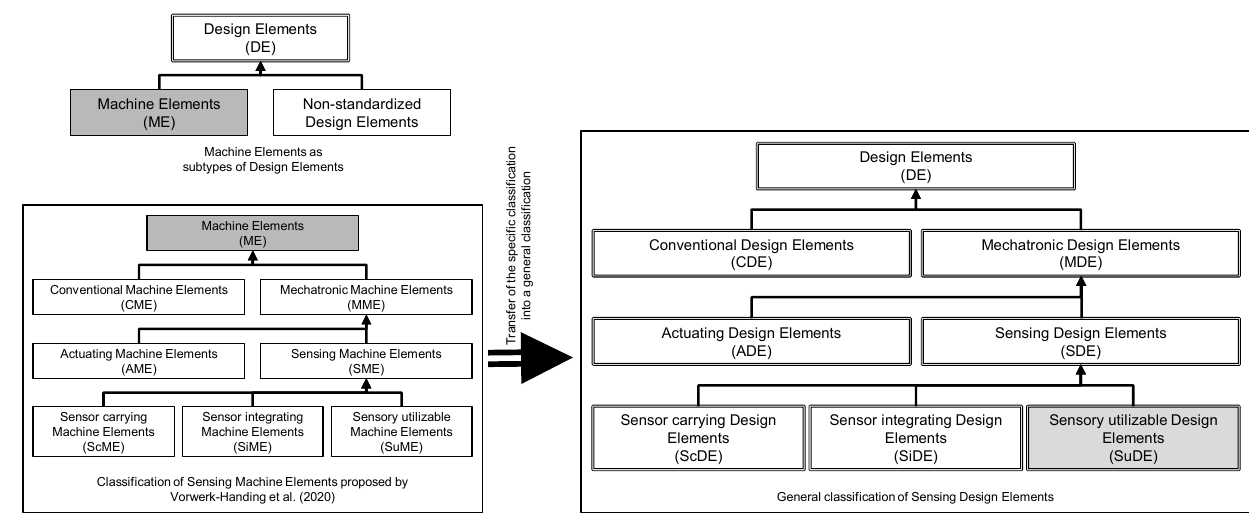
Figure 1. Machine elements can be described as a subgroup of design elements. Therefore, the definition of sensing machine elements made by Vorwerk-Handing et al. [6] is transferred to design elements.